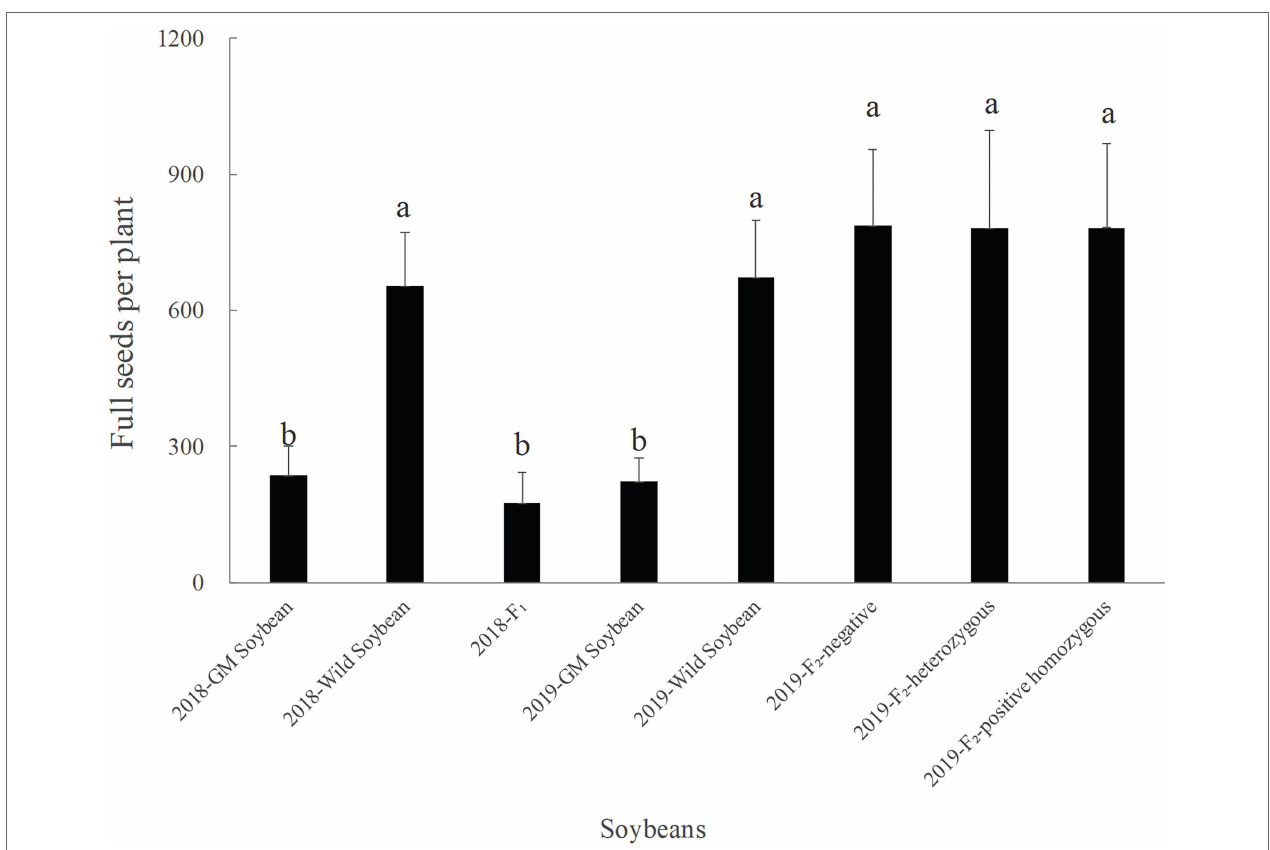
FIGURE 6 | Number of full grains per plant (grains) for genetically modified, wild soybeans, and hybrid progenies.